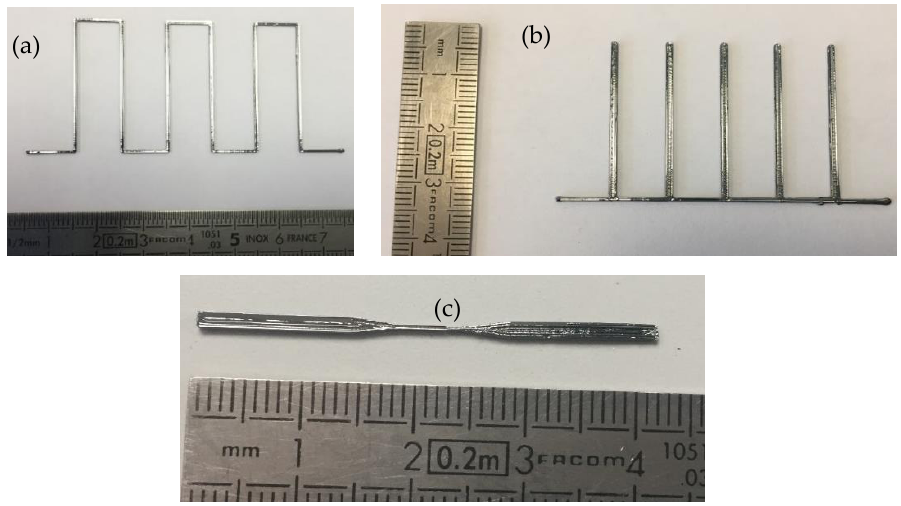
Figure 7. Linear 3D printed chalcogenide glass: ( a ) 700 × 500 µm slots shapes, ( b ) 1000 × 800 µm comb and ( c ) 1000 × 250 µm rectangular taper.